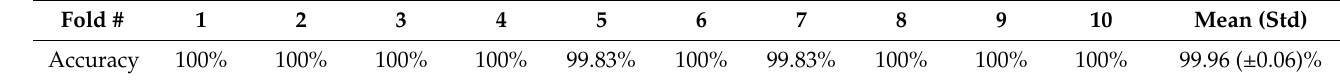
Table 3. Accuracy of proposed model.